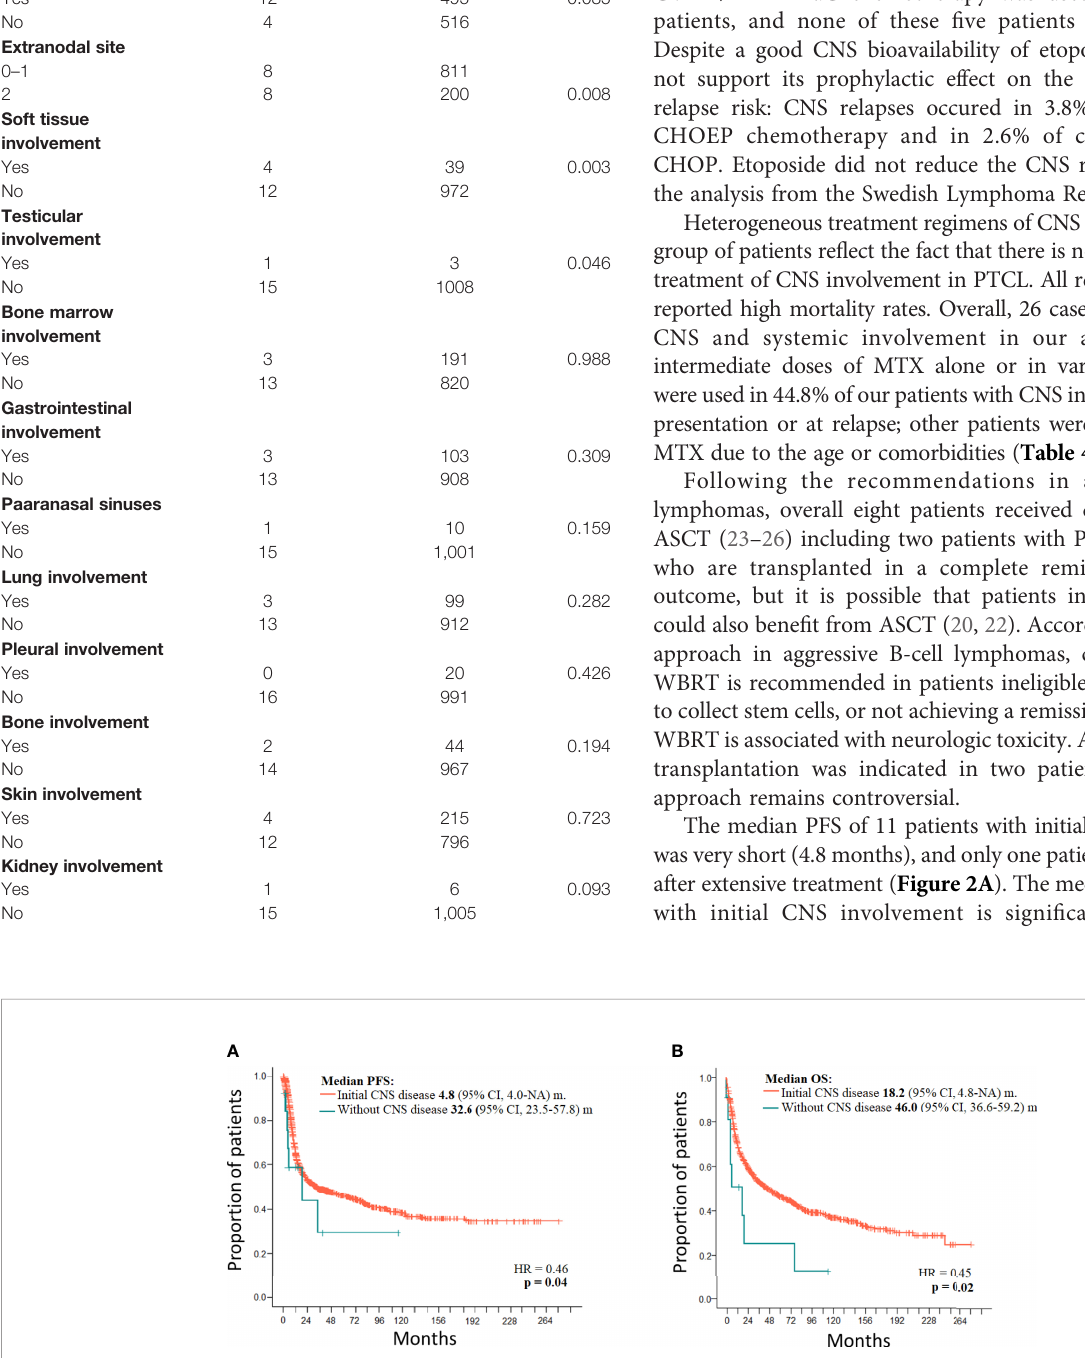
FIGURE 2 | (A) PFS of PTCL with initial CNS disease ( n = 11) and without initial CNS disease ( n = 1,027). (B) OS of PTCL with initial CNS disease ( n = 11) and without initial CNS disease ( n =